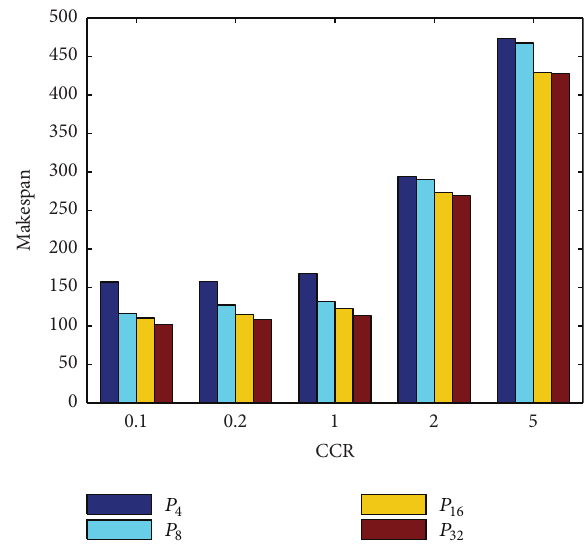
Figure 20: Average makespan of four algorithms under different processor numbers and the low communication costs; the number of tasks is 50.